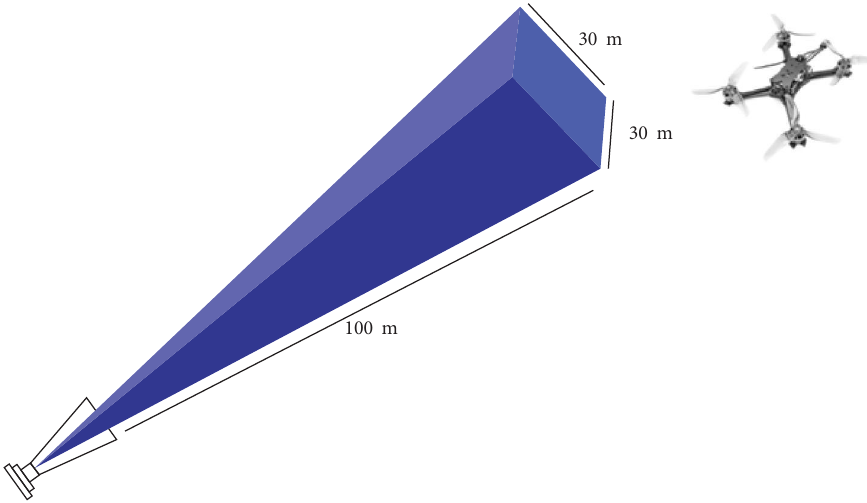
Figure 3: Expected radar coverage